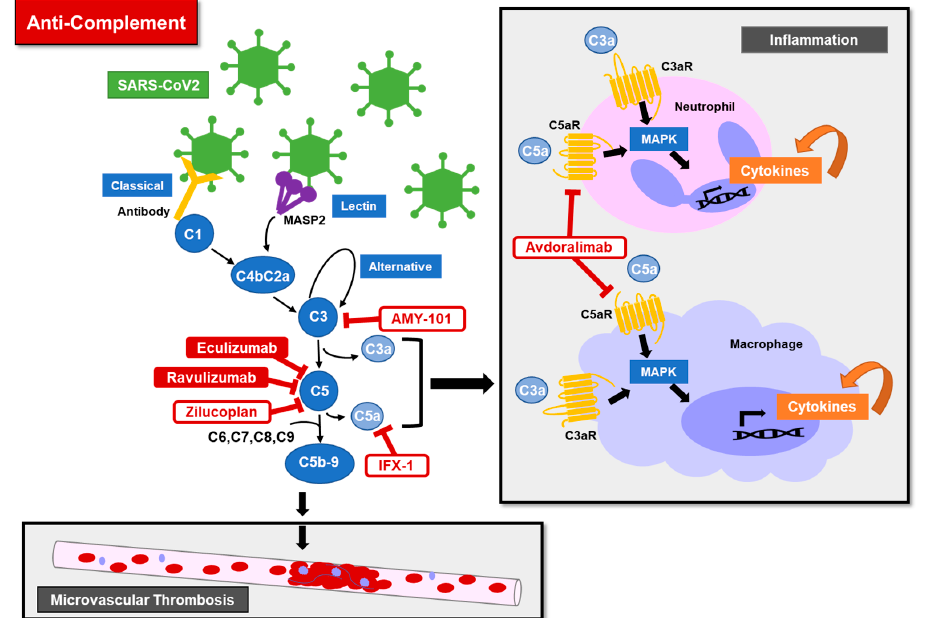
Figure 4. Schematic represents potential mechanisms of anti ‐ complement therapies under investigation to treat COVID ‐ 19 related inflammation and microvascular thrombosis. Viral activation of the classical, lectin, and alternative complement pathways are represented. Solid red drug names are FDA ‐ approved, and red outlined drug names are investigational.